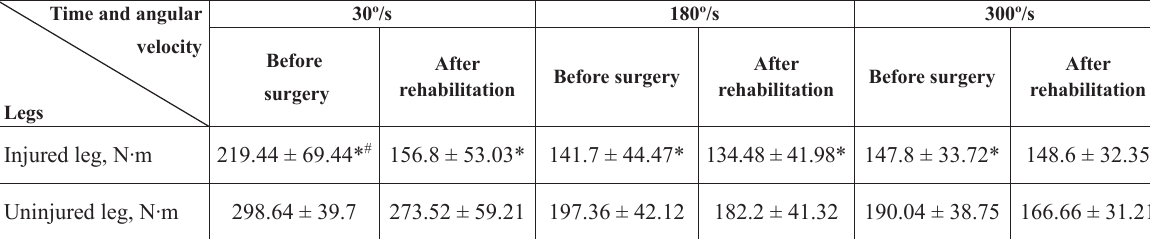
Note. * – p < 0.05 between injured and uninjured legs; # – p < 0.05 difference before surgery and after